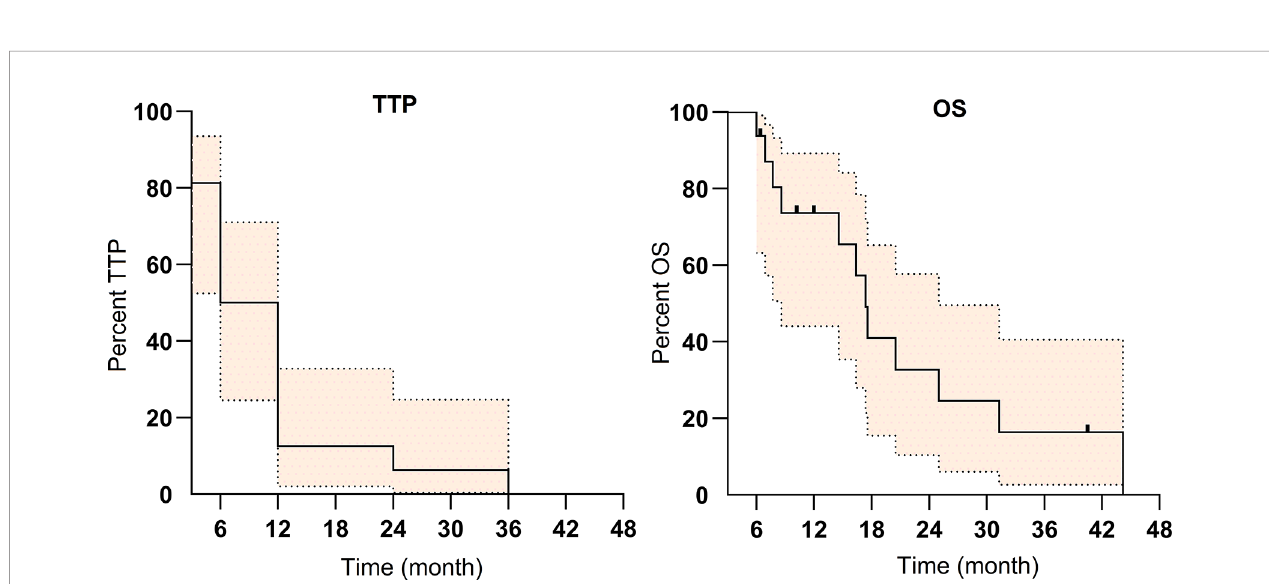
FIGURE 3 | The Kaplan – Meier survival curve of time to progression (TTP) and overall survival (OS) for the 16 patients with portal vein tumor thrombosis (PVTT) (colored area refers to 95% con fi dence